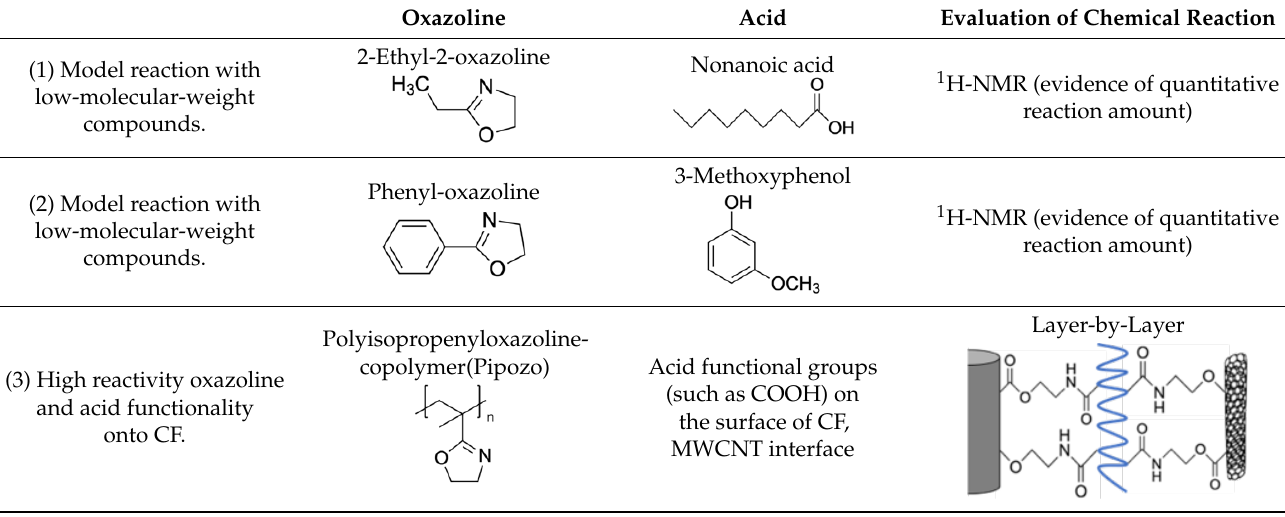
Table 2. Model reaction of oxazoline and acidic functional groups (COOH and phenol OH groups) and its application to surface modification, i.e., reaction between poly(2-isopropenyl-2-oxazoline) and COOH and phenol OH groups on the CF surface.